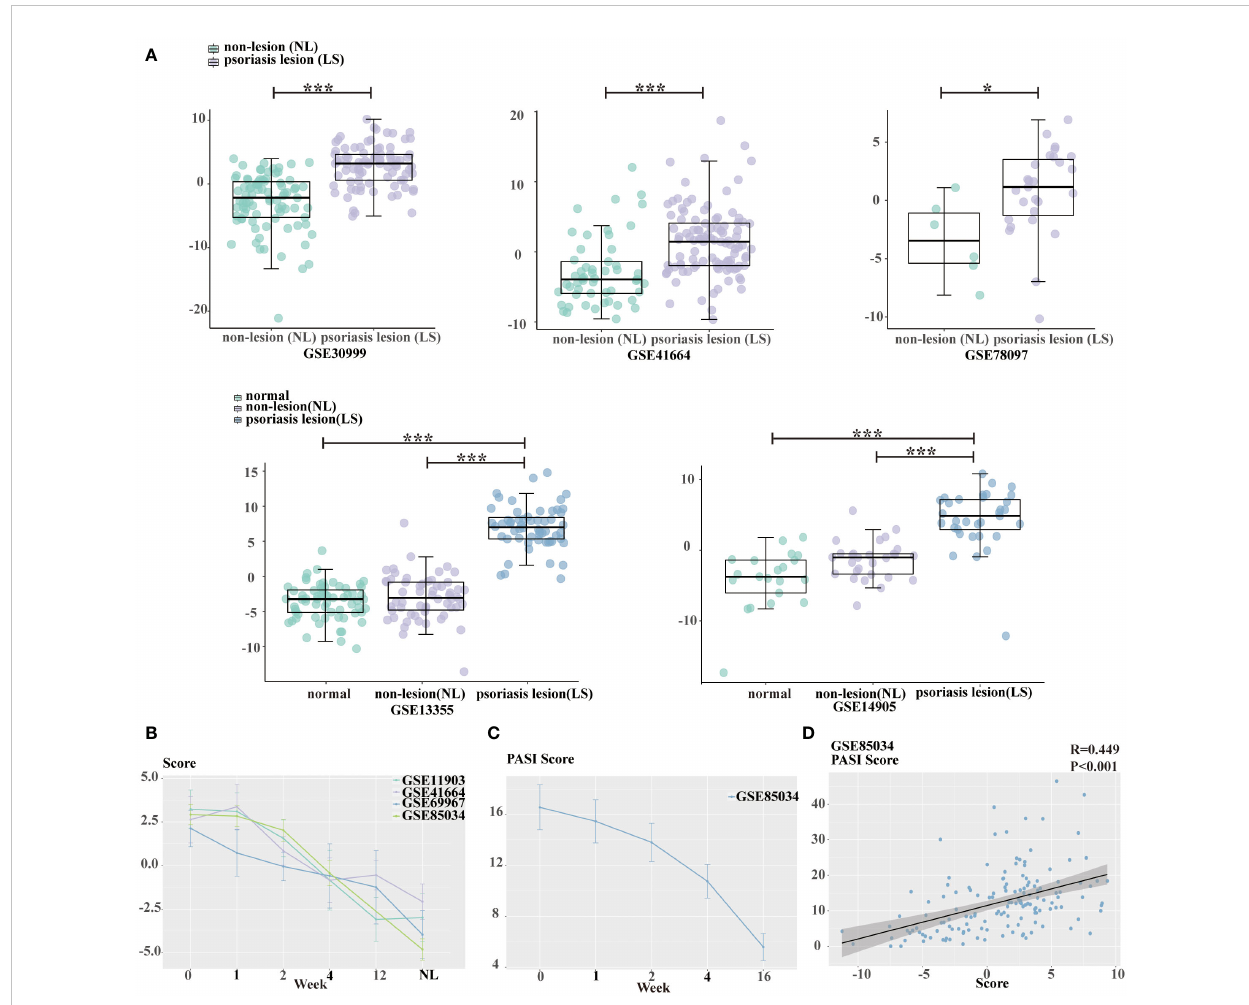
FIGURE 6 Estimation of glycolysis score. (A) Boxplot presenting the difference of glycolysis score among healthy skin, non-lesional psoriasis samples, and lesional psoriasis samples in GSE30999, GSE41664, GSE78097, GSE13355, and GSE14905. (B) The declining tendency of glycolysis score with treatment time in GSE11903, GSE41664, GSE69967, and GSE85034 cohorts. (C) The decreasing tendency of PASI scores with treatment time in GSE85034 cohort. (D) The correlation between glycolysis score and PASI score in GSE85034 cohort. *P<0.05,